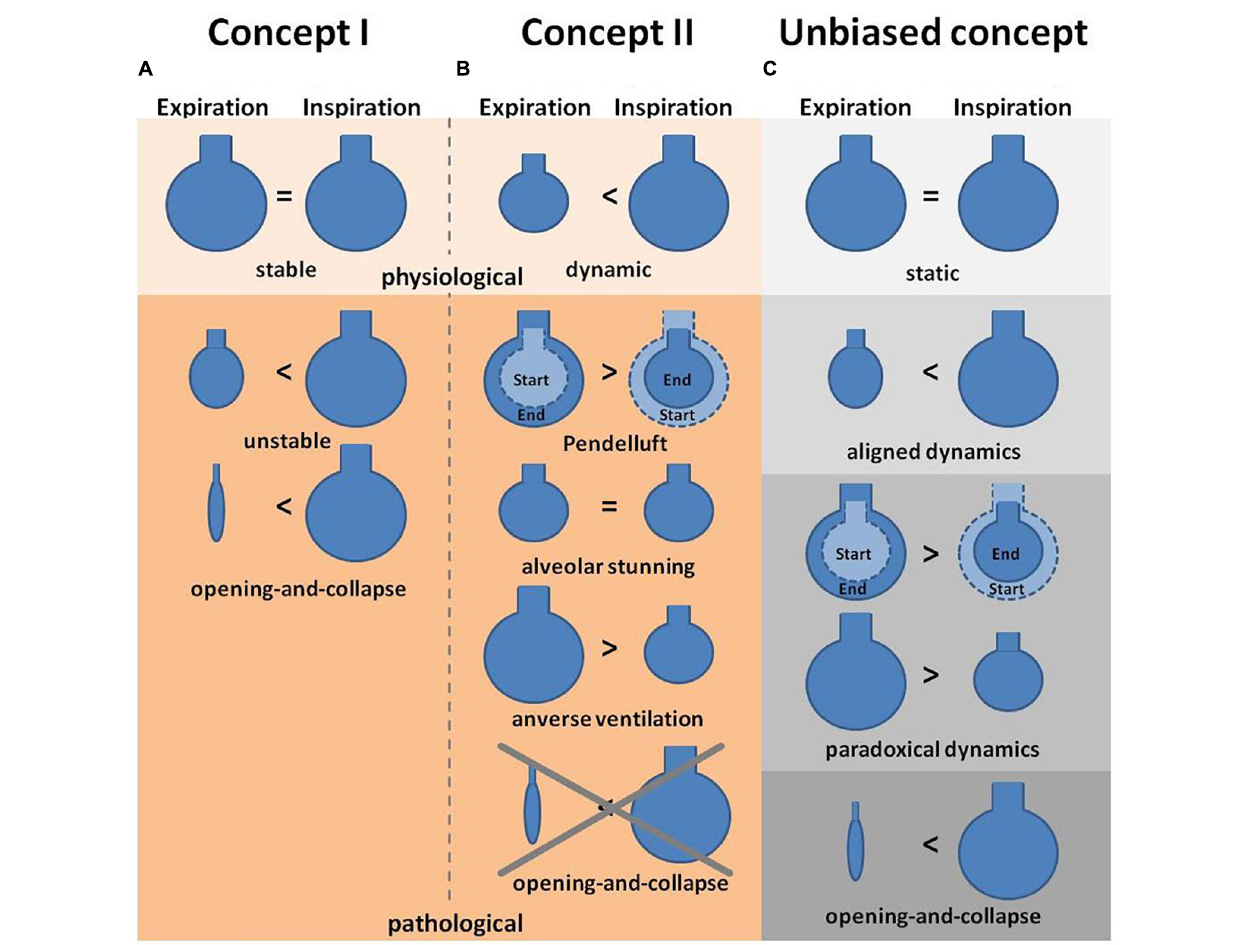
FIGURE 2 | Concepts of alveolar dynamics. (A) Concept I describes alveoli under physiologic conditions as stable (i.e., with no change in volume) during expiration and inspiration, whereas pathological situations lead to alveolar instability (defined as size and/or volume change) or even opening-and-collapse of alveoli (Carney et al., 1999). (B) Concept II describes alveoli under physiologic conditions as alveoli that increase in volume during inspiration and contract during expiration, whereas pathological conditions are associated with an arrest of alveolar dynamics (alveolar stunning) or paradoxical motions, such as Pendelluft or